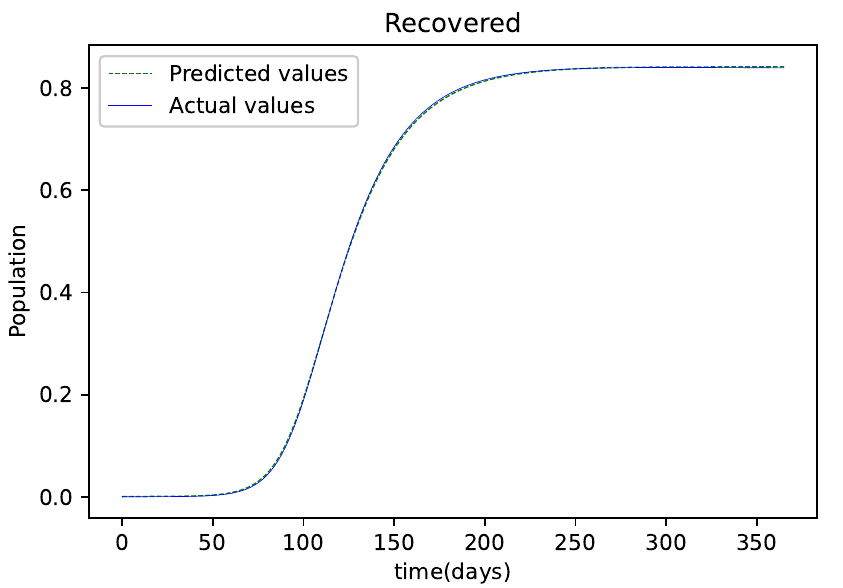
Figure 5. The graphs shows the results of the predicted values of the Recovered and the actual values of the recovered from the Mathematica generated data.